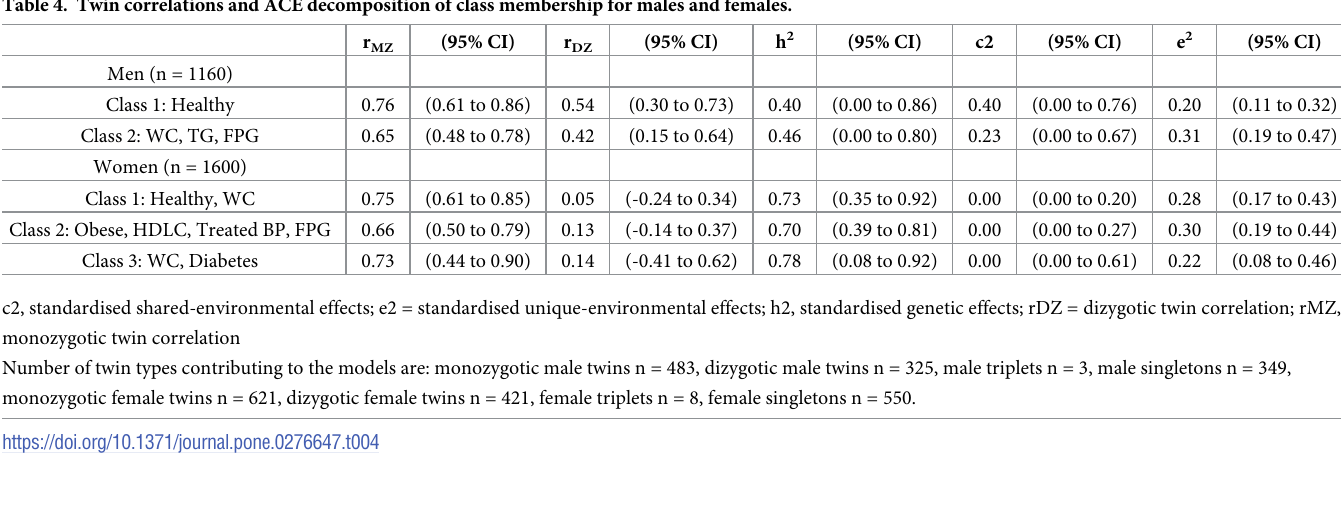
1–4, respectively. The distribution of other cardiometabolic risk factors indicated clinical pro-